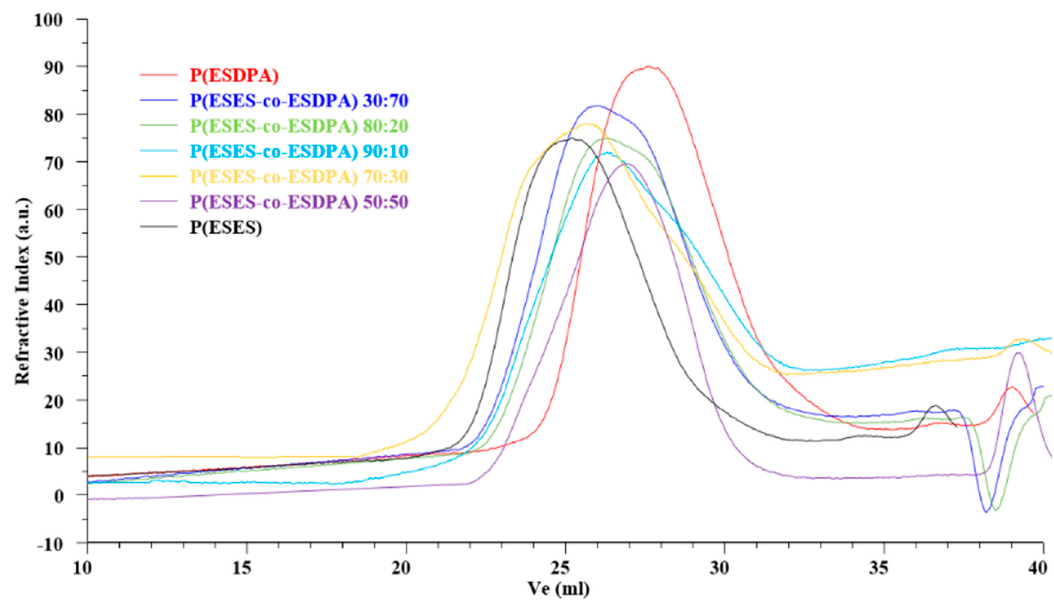
Figure 6. Overlay of the SEC traces of the P(ESES-co-ESDPA) copolymers and of their homopolymers, recorded using DMF as eluent.